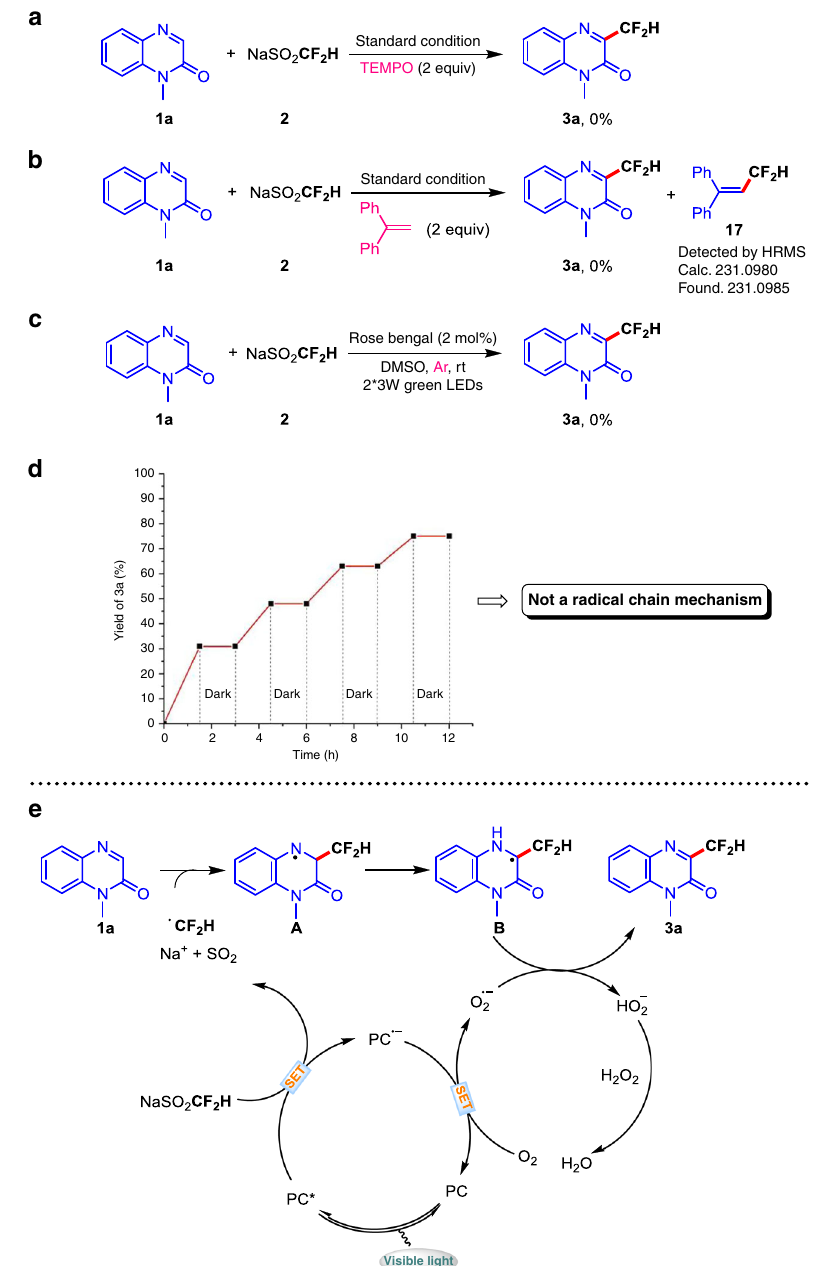
Fig. 7 Mechanistic investigations. a Investigation on the effect of TEMPO. b Radical trapping with 1,1-diphenylethylene. c Investigation on the effect of oxygen. d Light/dark experiment. e Proposed reaction